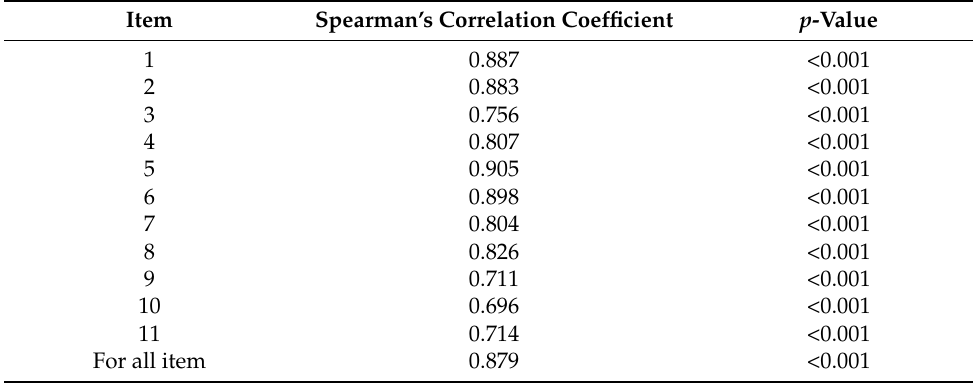
Table 3. Spearman’s correlation coefficients.